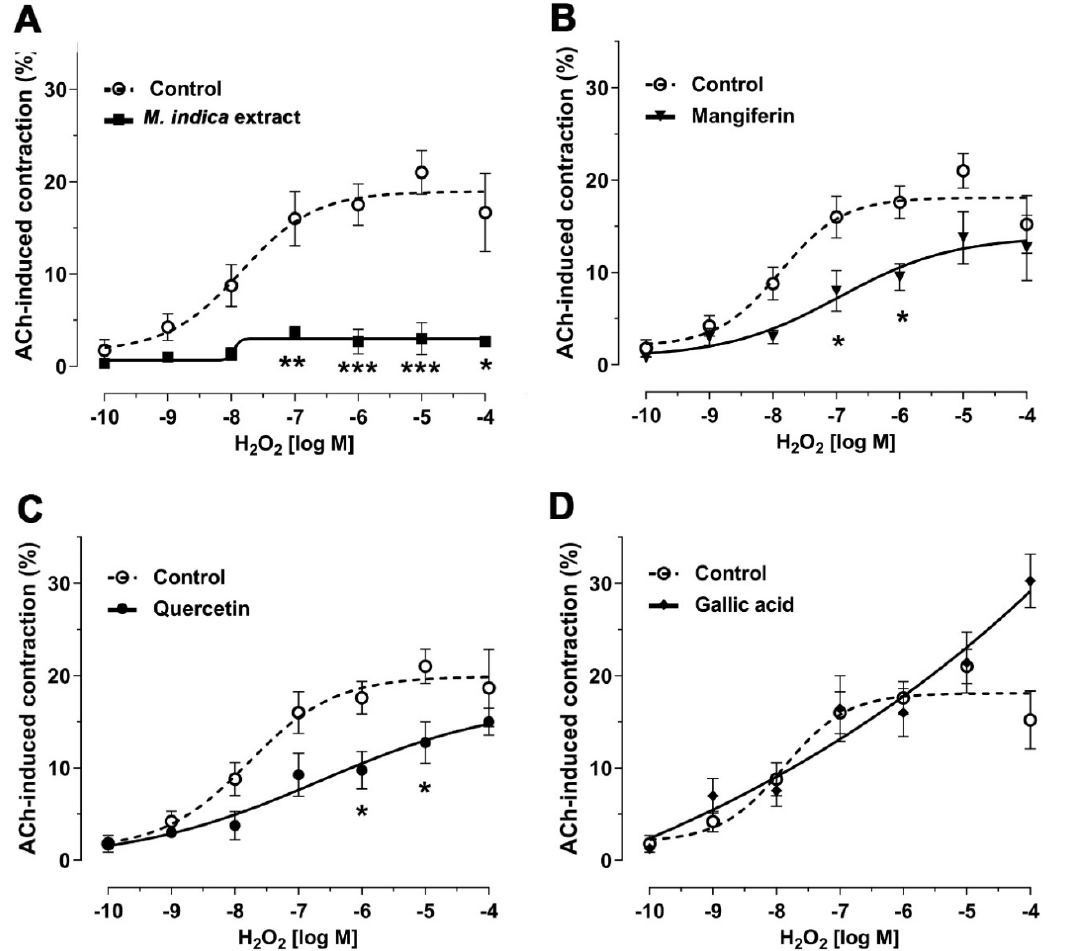
Figure 5. Antispasmodic activity of lyophilized extract of M. indica (MIE) and its main metabolites reduced contraction to H 2 O 2 . Rat ileum muscle tissue was pre-incubated with MIE (100 µg/mL; ( A )), mangiferin (10 − 5 M; ( B )), quercetin (10 − 5 M; ( C )), or gallic acid (10 − 5 M; ( D )) for 20 min before contraction with H 2 O 2 (10 − 10 to 10 − 4 ). In all panels, control represents the contractile response to H 2 O 2 of an ileal segment without pre-incubation with MIE, mangiferin, quercetin, or gallic acid, as appropriate. Each point represents the mean of maximal response in percentage ± SEM of five experiments ( n = 5). * p < 0.05; ** p < 0.01; *** p < 0.001 vs. control.